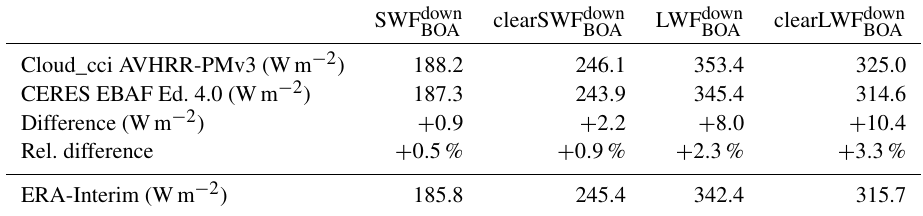
Table 8. Multi-annual (2003–2016), latitude-weighted, global mean downwelling broadband shortwave fluxes and longwave fluxes (SWFs and LWFs) at bottom of atmosphere (BOA) inferred from Cloud_cci AVHRR-PMv3 dataset for all-sky and clear-sky (clear) conditions. The values are compared to equivalents inferred from Clouds and the Earth’s Radiant Energy System (CERES) Energy Balanced and Filled (EBAF) surface fluxes. All values are given in watts per square metre (Wm − 2 ). In addition, differences and relative differences (Cloud_cci- CERES) for all fluxes are reported. For comparison, ERA-Interim values are listed as well.